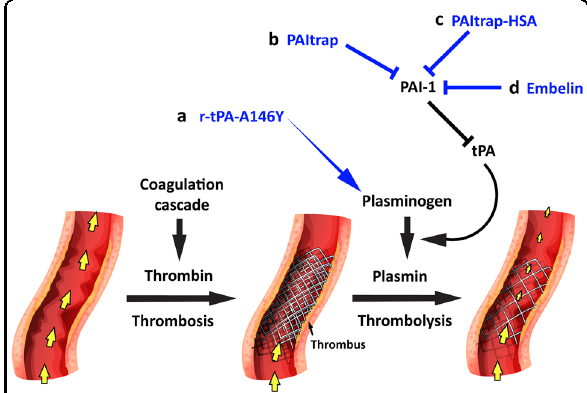
Fig. 4 Thrombolytic agents based on r-tPA or targeting tPA or PAI-1. a The high-ef fi ciency R-tPA-SPD-A146Y agent demonstrated 5-fold increased fi brinolytic activity and 30-fold increased PAI-1 resistance compared to clinical r-tPA. b A recombinant PAI-1 inhibitor, PAItrap, derived from the inactive catalytic domain of uPA. c PAItrap fused with HSA demonstrated prolonged circulation time and enhanced thrombolytic effects. d A small-molecule natural product, embelin, demonstrated high inhibitory potency against PAI-1 and suppressed in fl ammation and thrombosis in a sepsis-induced DIC model. Blood fl ow is indicated by the yellow